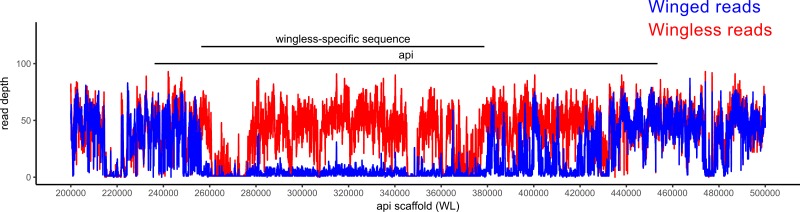
Wingless, but not winged reads, map to the wingless-specific region.Shown is the read depth of pool-seq data from alfalfa pea aphids (winged: blue, wingless: red) mapping against the reconstructed WL api scaffold. The wingless-specific sequence and recombination mapping defined api region (‘api’) are indicated.